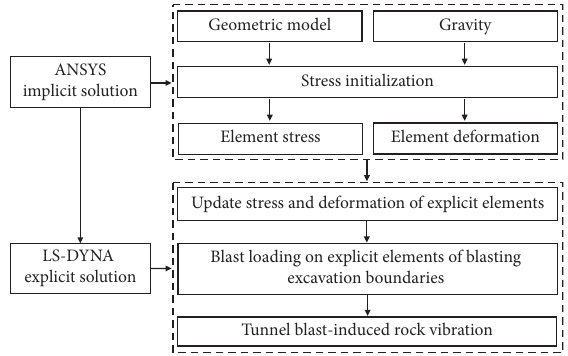
Figure 12: Overall flowchart of the implicit and explicit solutions in sequence in